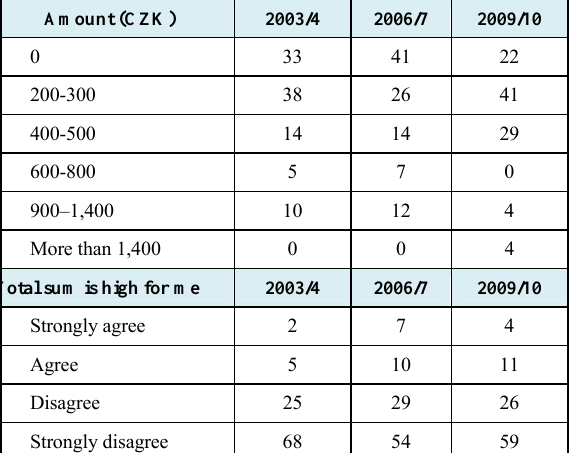
F INANCIAL REQUIREMENTS FOR STUDYING IN DISTANCE ON - LINE COURSES